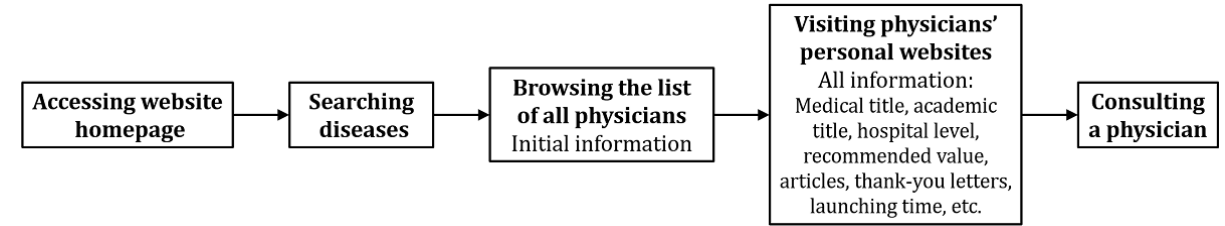
Figure 1. Patient decision-making process in online health communities.